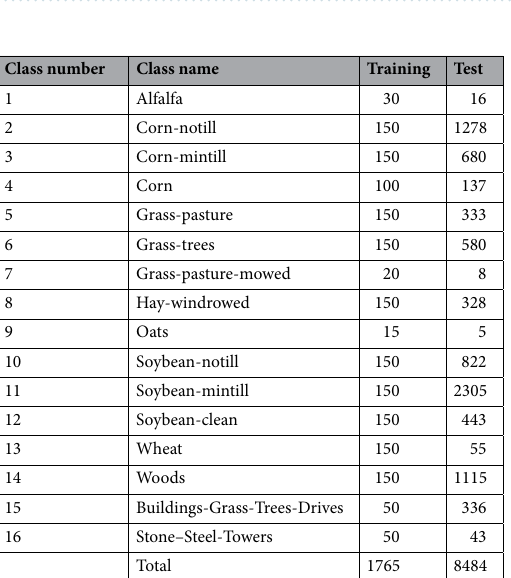
Figure 4. Kennedy Space Center. ( a ) False-color map; ( b ) Ground-truth map.